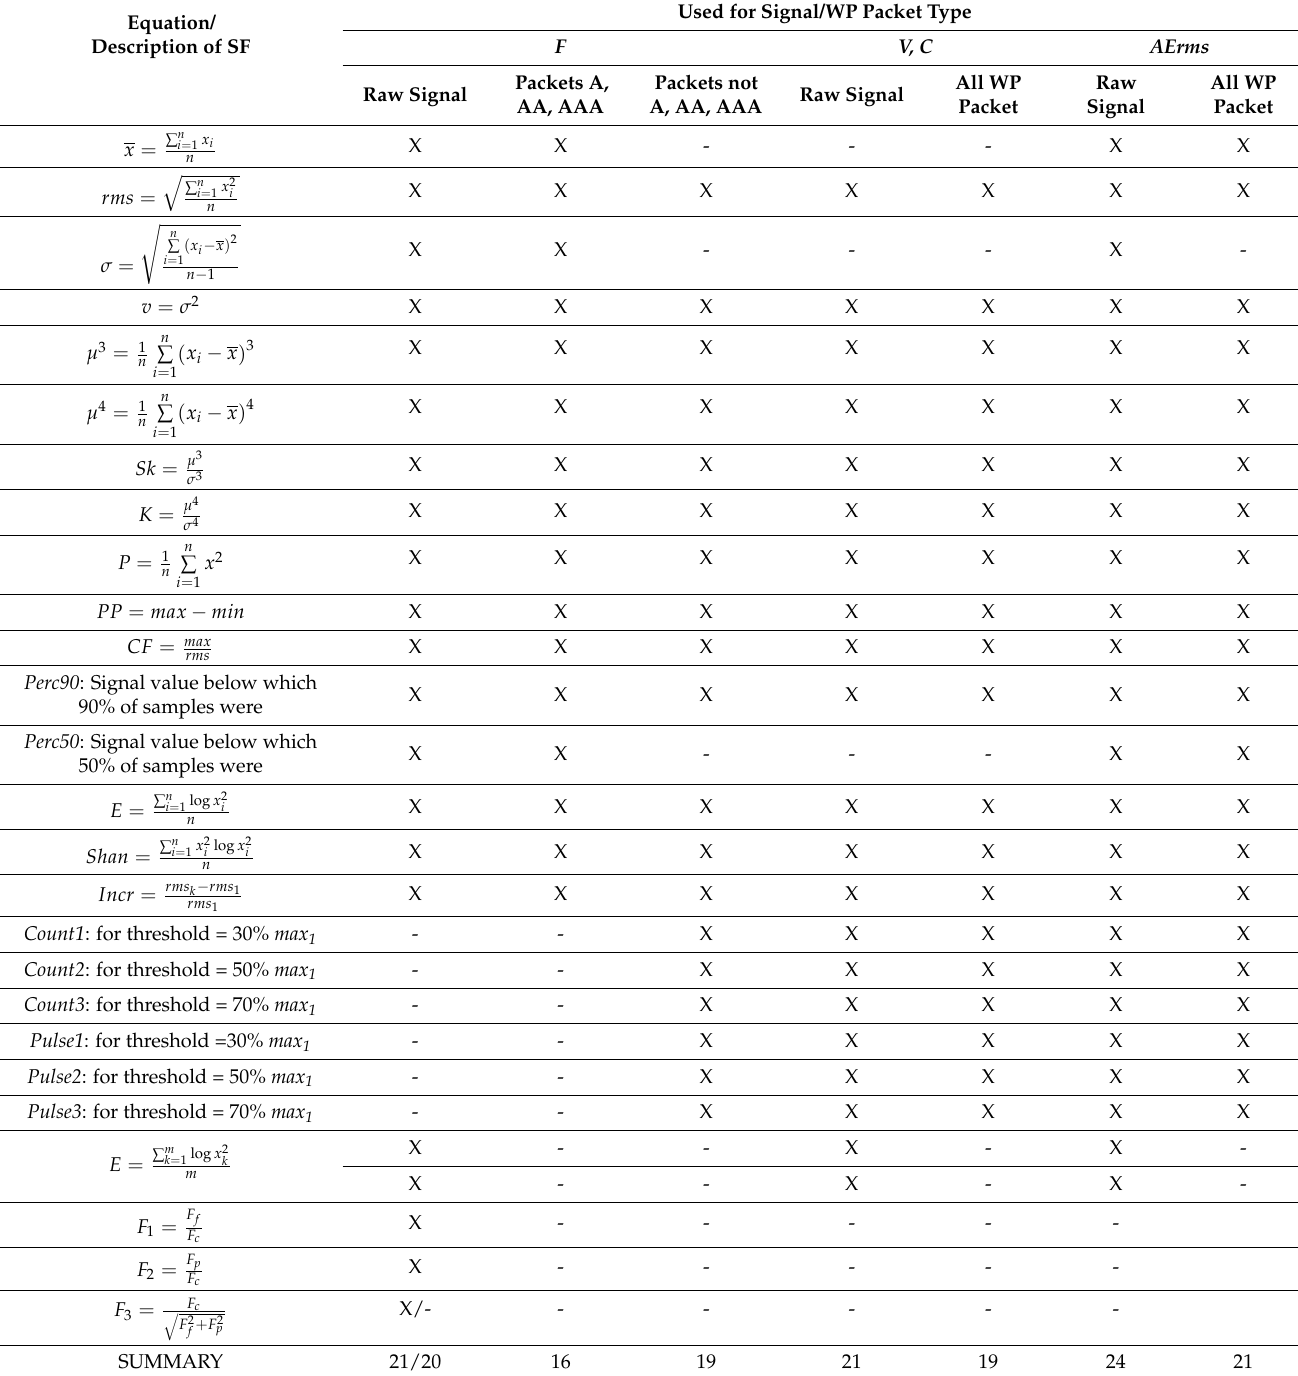
Table 2. General description of signal